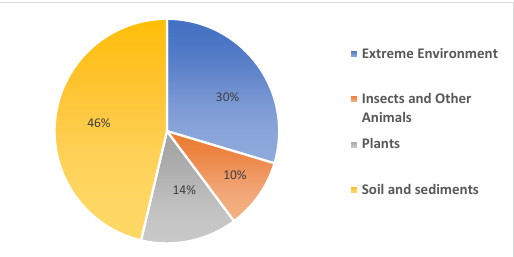
Figure 1. Distribution of new Streptomyces spp. sampled from different terrestrial sources. Soils and sediments sources provide 46% of the new Streptomyces spp., 30% from extreme environments, 14% from plants and 10% originated from insects.